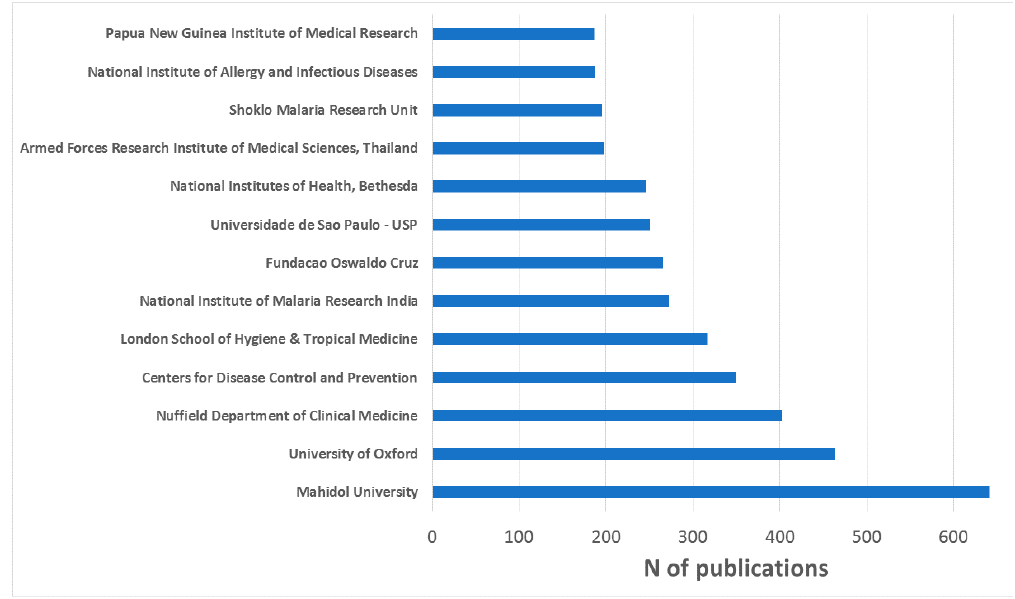
Figure 5. Main institutions in terms of scientific publication in malaria and P. vivax.